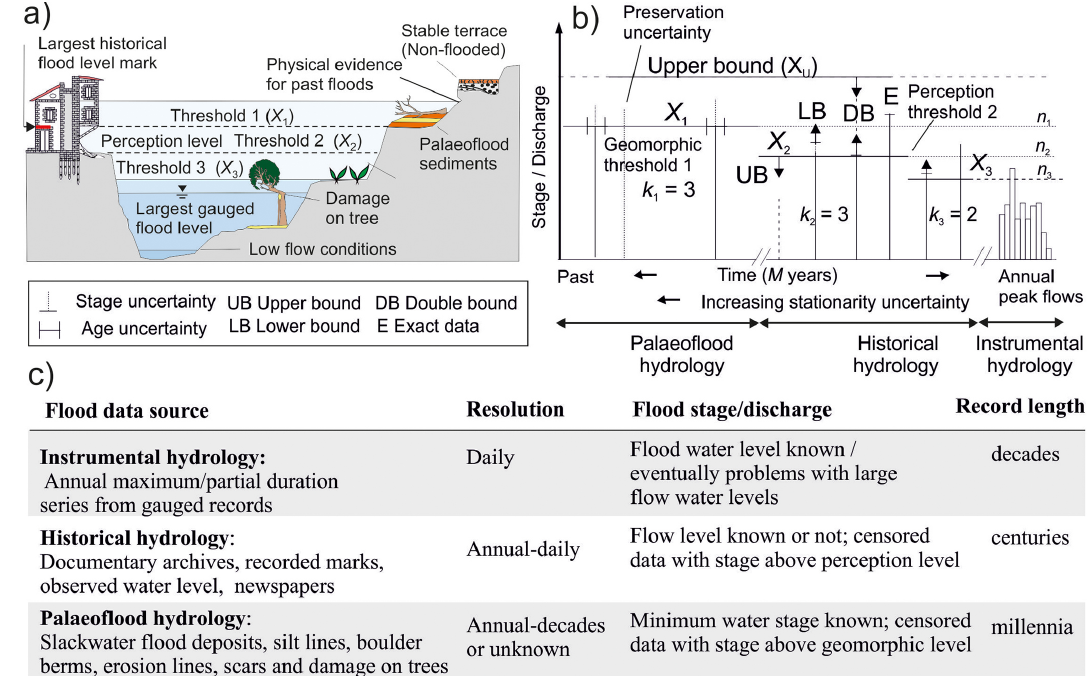
Figure 1. Sources of quantitative flood information. (a) Sketch of a cross section showing various flood level indicators from palaeofloods (sediments and damage on trees), and documentary-based floods (i.e. those able to cause damage or socio-economic disruption). For historical hydrology, only floods exceeding a flood level related to a perception threshold ( X i ) over a period of n i years ( n 1 >n 2 >n 3 ) are recorded. Palaeofloods from stratigraphic records are related to geomorphic thresholds. (b) Organization of historical and palaeoflood data, using the described thresholds ( X i ), and multiple types of observations to support flood frequency analysis. K i corresponds to the number of flood peaks during the last n i years that exceeded the X i threshold but not the X i − 1 threshold. Upper bound level ( X u ) may be used to limit the maximum discharge. Data types: E: flood peak is known. LB: flood was bigger than X i which is known; UB: the upper flood level of known magnitude ( X u ) was not exceeded over a certain time period. DB: flow level was within the interval given by X u and X i . (c) Data source characteristics, timing, stage information, and typical temporal framework of systematic (instrumental) and non-systematic data (palaeoflood and documentary evidence). Modified after Benito and O’Connor